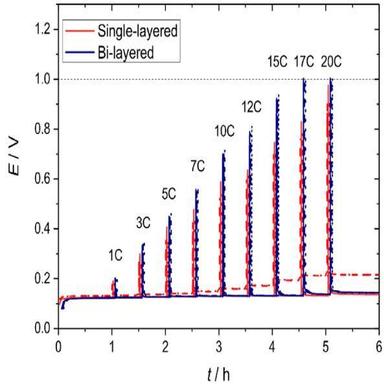
Power test conducted with HCCs consisting of single- and bi-layered negative electrodes.